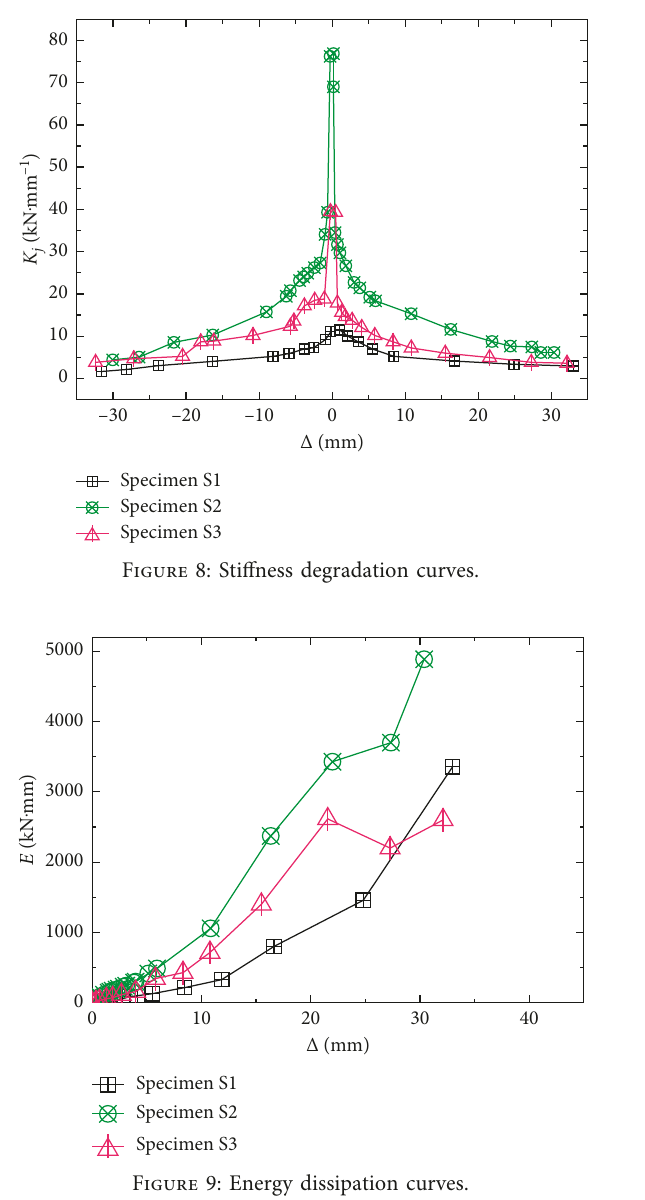
Figure 9: Energy dissipation curves.